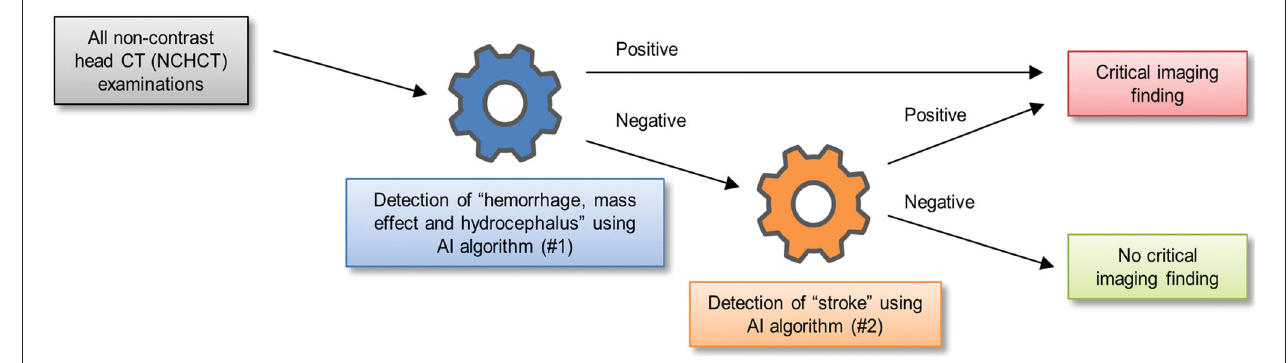
FIGURE 6 | A schematic of one way in which two sequential algorithms can be integrated into triage workflow for exam classification